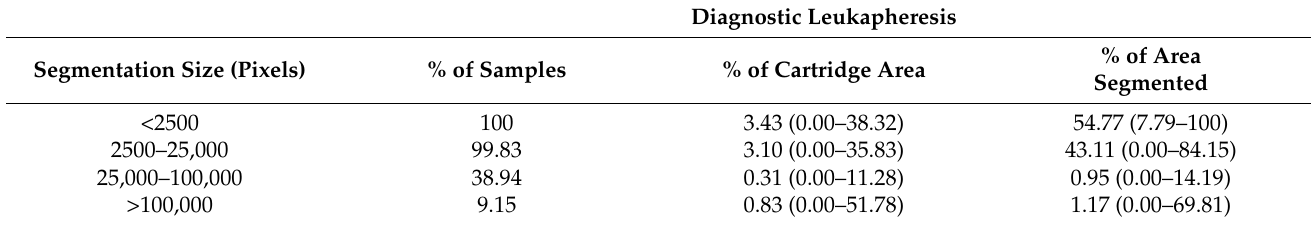
Table 2. CellSearch segmentation sizes in blood and DLA samples. The percentage of samples with different segmentation sizes present in whole blood and DLA samples, the mean percentage of the total cartridge area covered, and the mean percentage of the total segmented area by the different CellSearch segmentation sizes. The ranges are shown in parentheses.